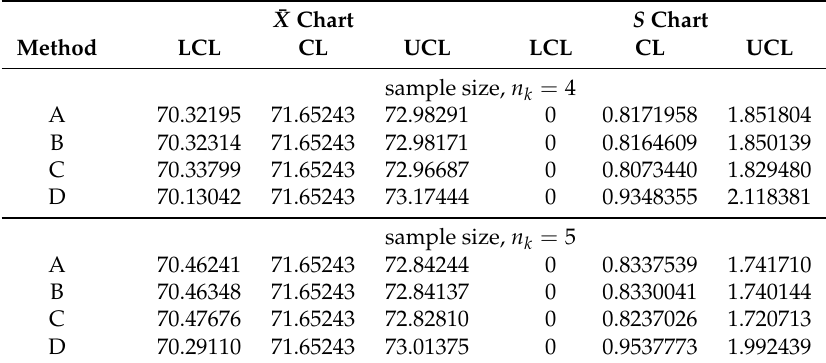
Table 5. Control limits for the ¯ X and S charts for Example